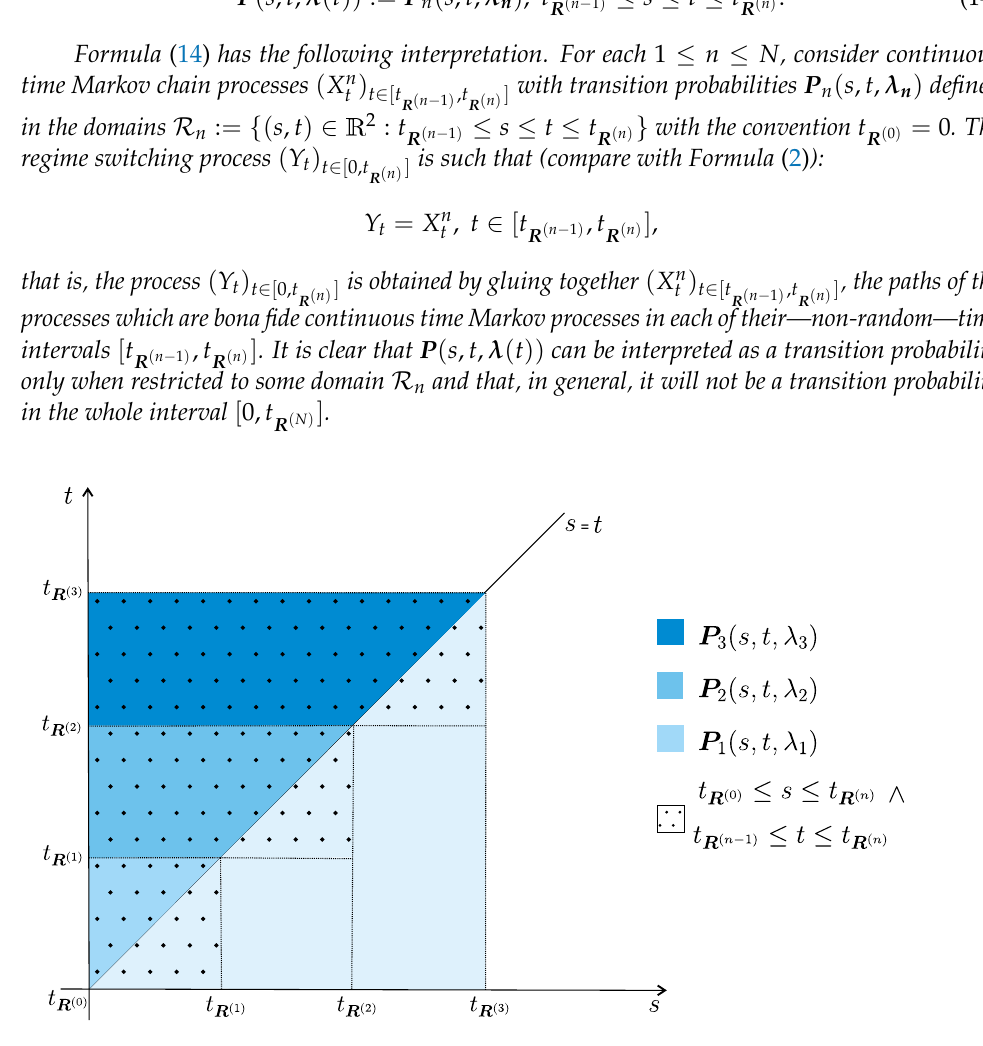
Figure 1. A representation of (cid:101) P ( s , t , λ ( t )) in Formula (12) for the first three initial